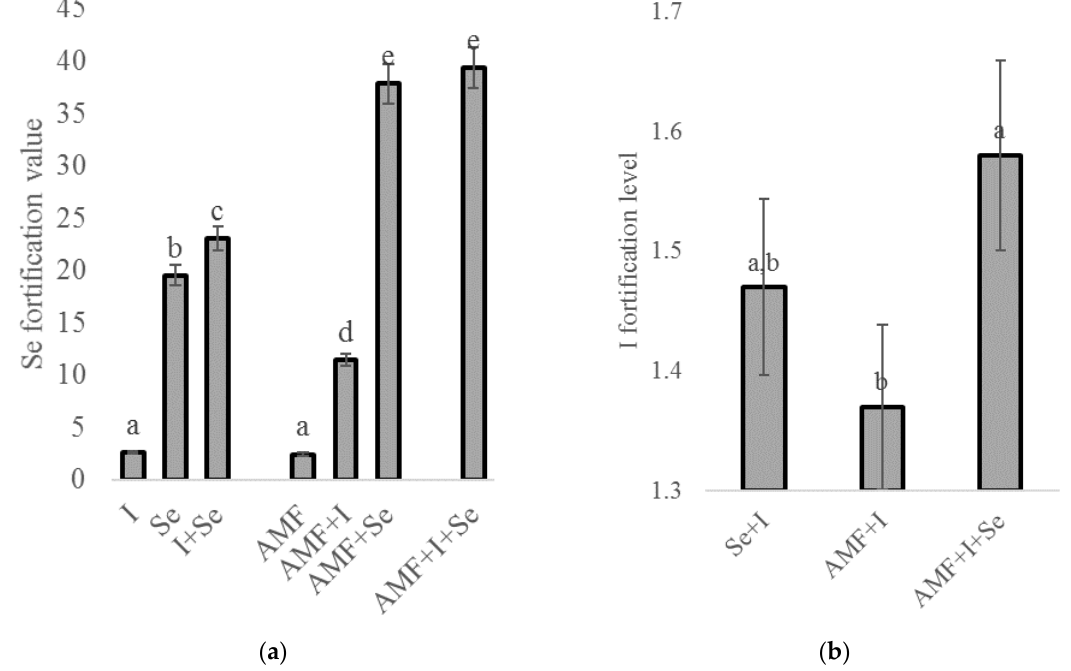
Figure 1. Effect of AMF, Se, and I biofortification on Se ( a ) and I ( b ) biofortification values. Values followed by the same letter are not significantly different according to Duncan’s test at p < 0.05.